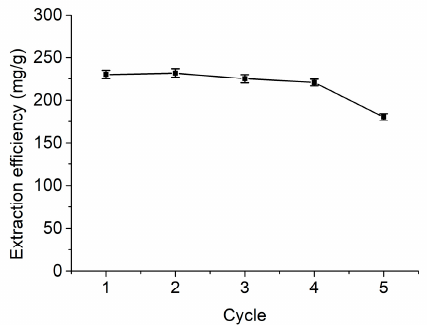
Figure 4. The recycling of recovered DES. One g of powdered dried lotus leaf was added to 20.0 mL of the DES. After extraction by the UAE-DES method, the DES extracts were adsorbed with 4.0 g of D101. After the adsorption procedure, the resin was desorbed and the DES were reused. The DES were evaporated to remove water and an appropriate amount of water was added for the next cycle of extraction.